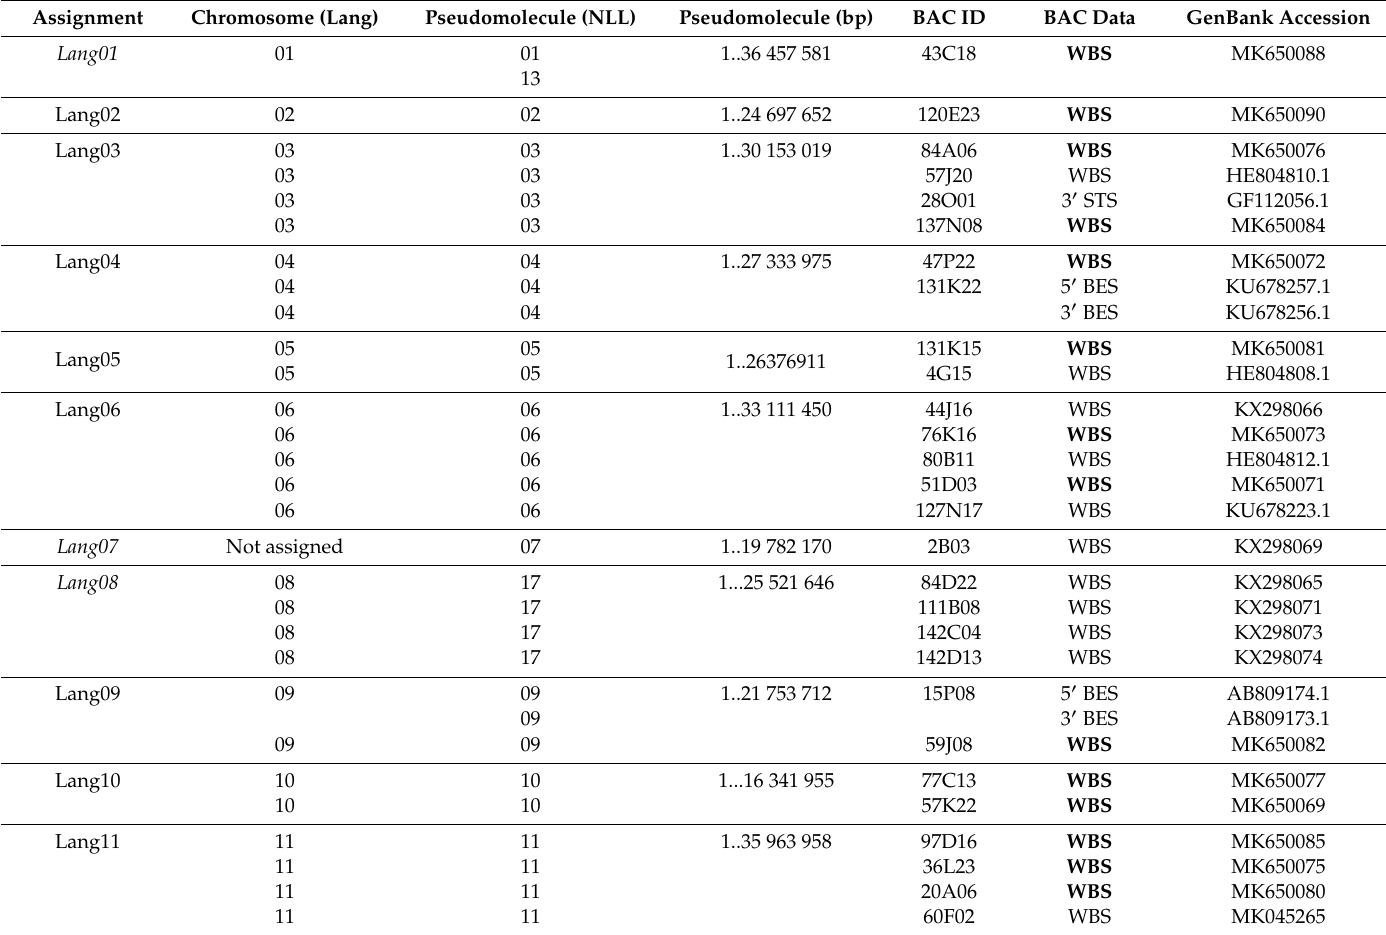
Table 2. Bacterial artificial chromosome (BAC) clones used for the chromosome and pseudomolecule integration in L. angustifolius